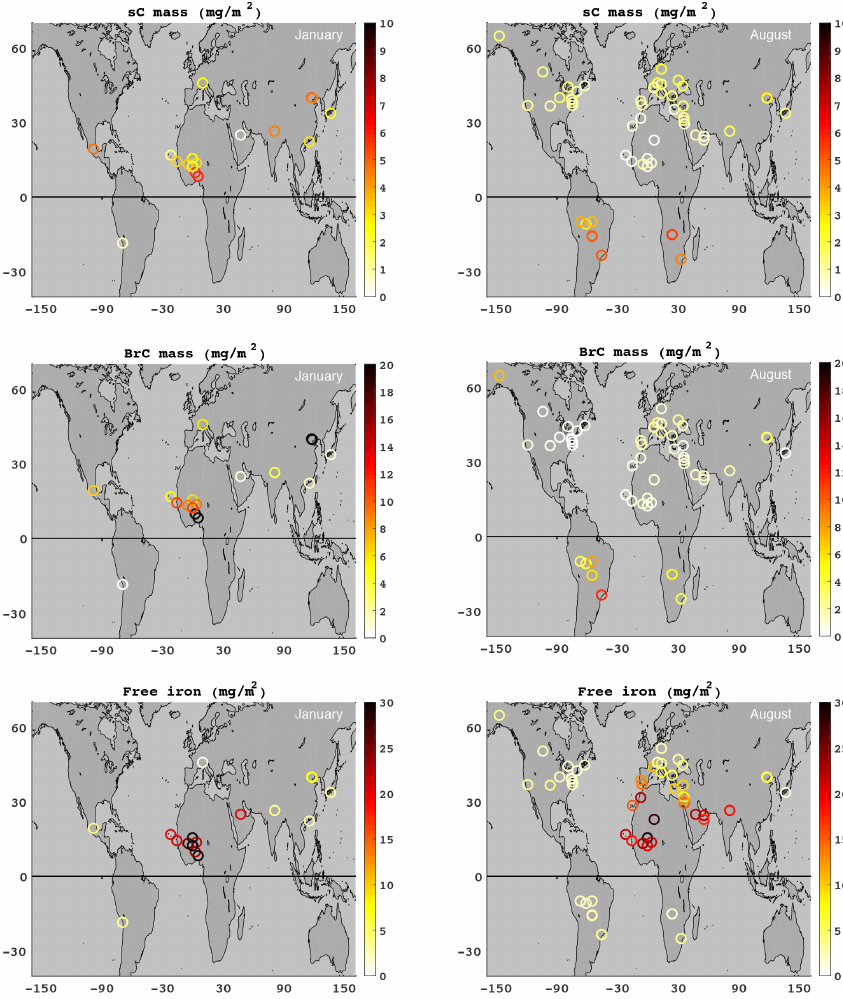
Figure 8. Column mass concentrations of sC (top row), BrC (middle row), and iron oxide (bottom row) retrieved from Level 2.0 AERONET data for January (left column) and August (right column). Minimum number of retrievals is 25 for each